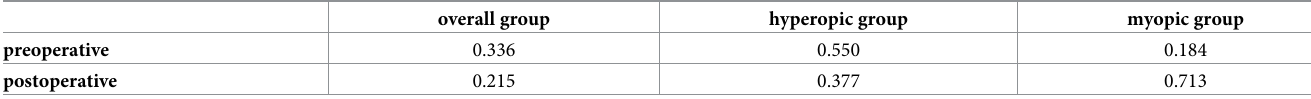
Table 2. Correlation between angle κ and SI in all three groups, pre- and postoperatively (p-values).